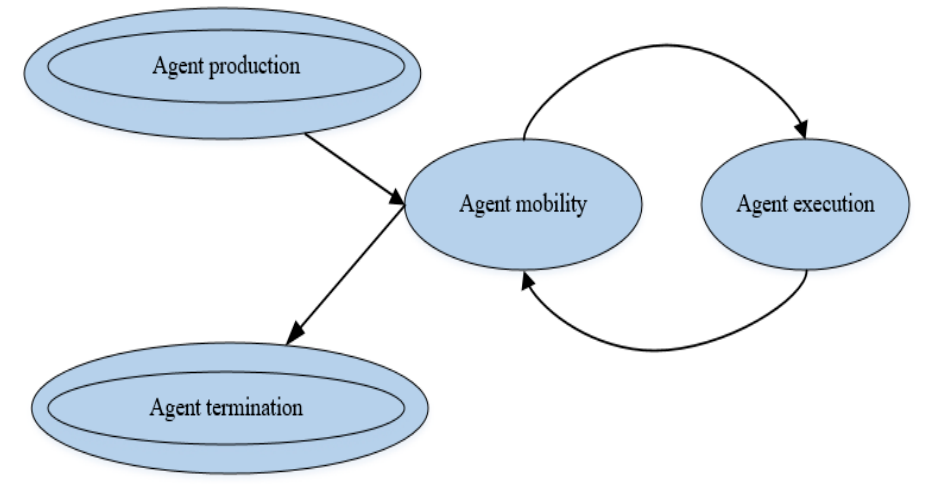
Figure 13. State transition diagram of mobile agent.